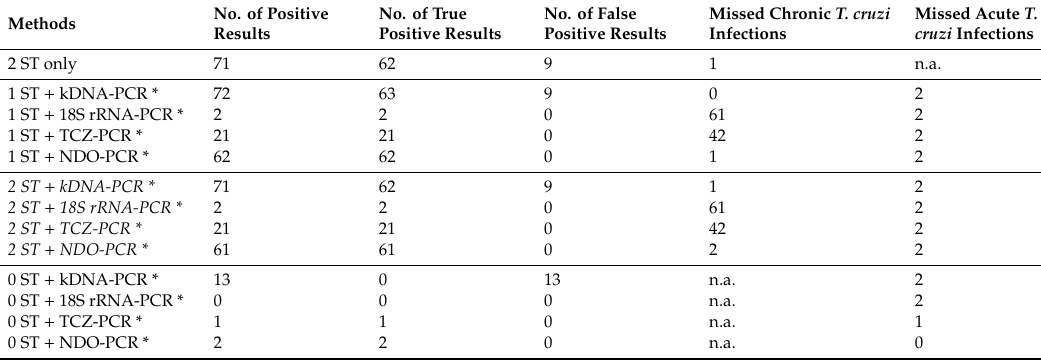
Table 5. Comparison of di ff erent methods and combinations of methods related to the 87 sequenced samples (65 T. cruzi , 14 T. rangeli , 8 H. sapiens ). ST: serologic test positive; * PCR positive in at least one run, n.a.: not applicable. One rapid test combined with NDO-PCR showed the best